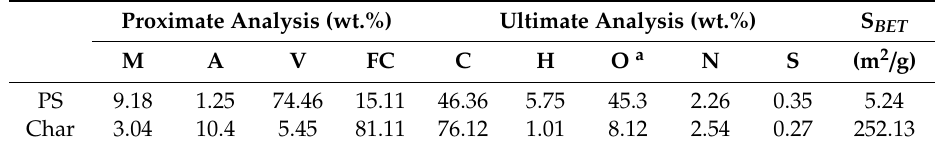
Table 1. Ultimate and proximate analyses of pine sawdust (PS) and char samples b.